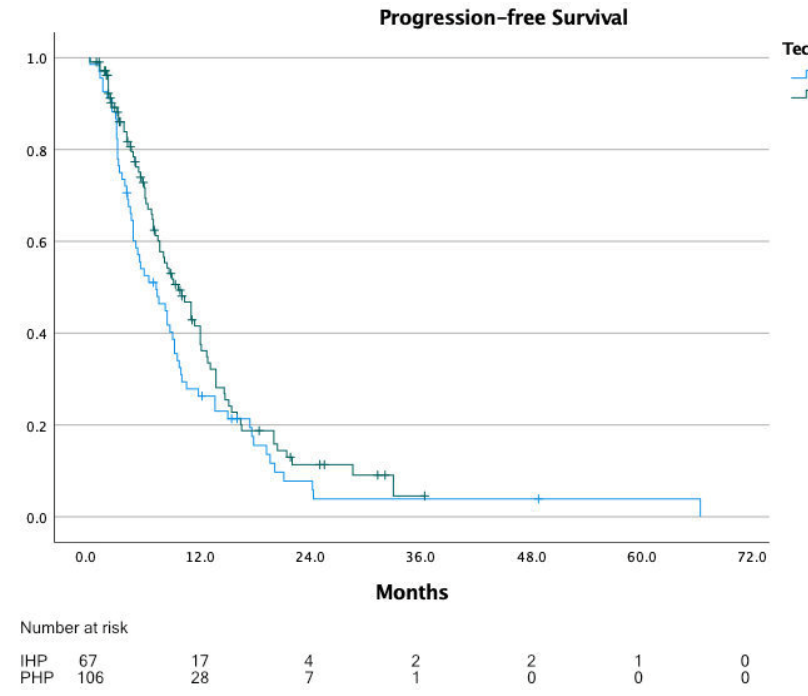
Figure 4. Progression ‐ free survival.